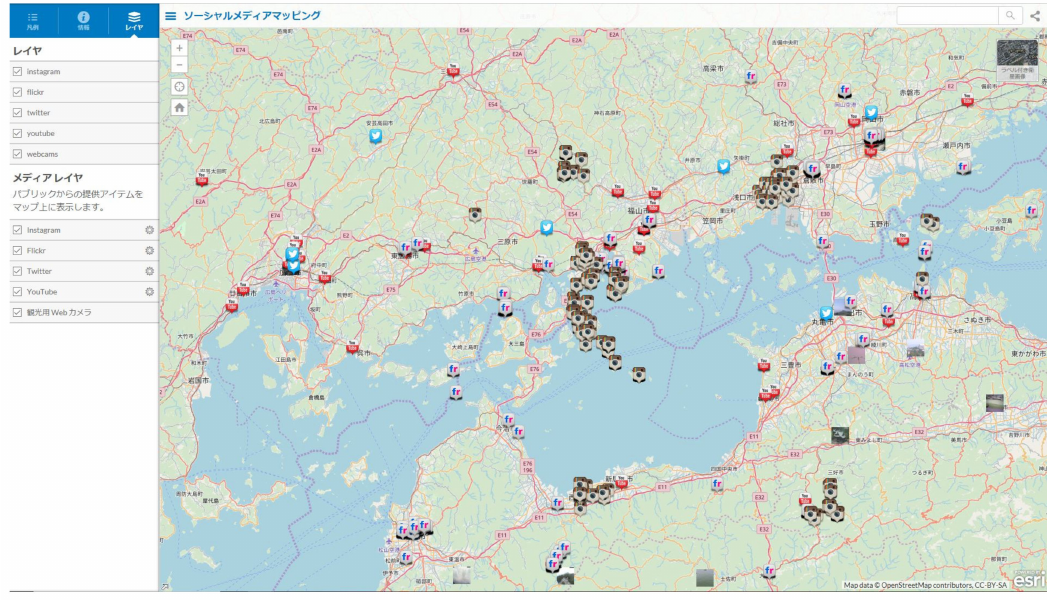
Figure 6. A screen of the Setouchi Region displayed using the function of social media